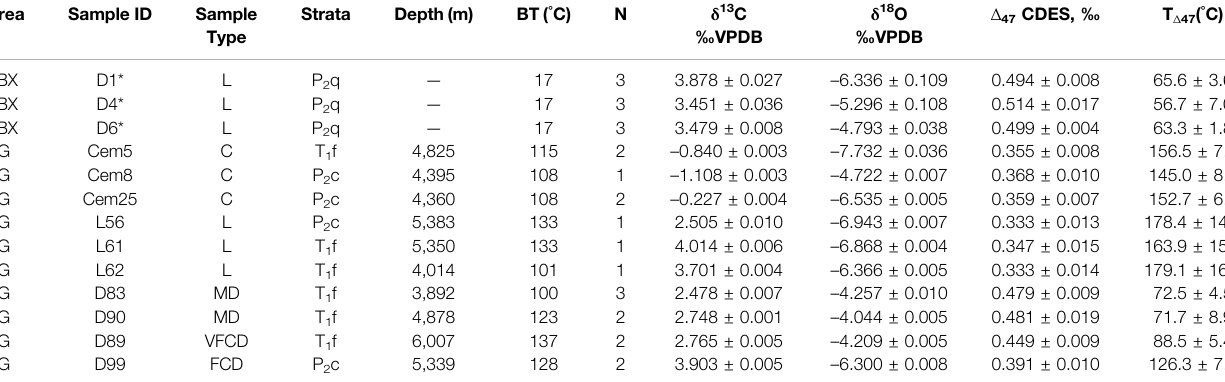
TABLE 1 | The δ 13 C, δ 18 O, Δ 47 , and T Δ 47 values of the carbonate samples from the XBX outcrop and the PG gas fi eld in the Sichuan Basin.